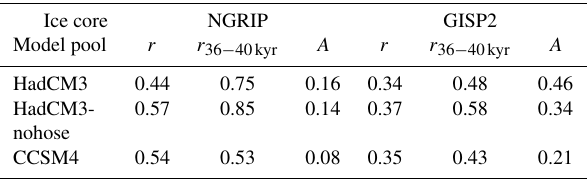
Table 3. The agreement between the PSR and the ice-core record. A is the ratio between the standard deviation of the two time